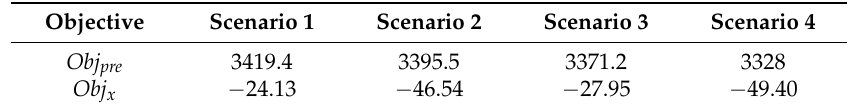
Table 9. The index values of 15 schemes by different scenarios